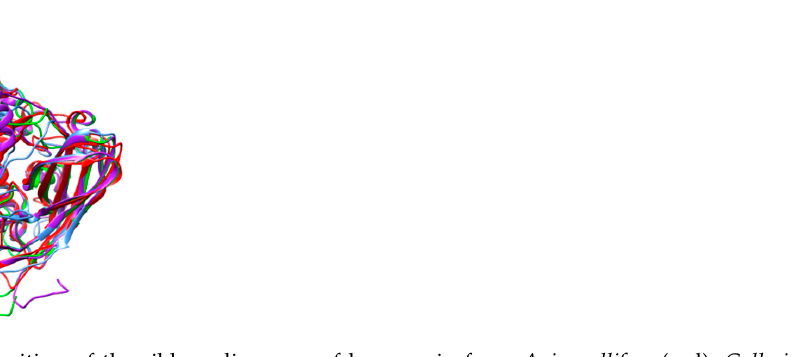
Locusta m. DYFYSDLCNAVYVTPEEYDSDR--VQVRARQYRLNHKAFTYKIYVKSNEEQQASVWIYIGPEYDEYG Galleria m. EYTNFNVTNHLHLNEIECNNVINTKSVLVQRTRLNHKVFTVRVNVKSGVAKHVTVRFFLAPKYDSVG Locusta m. KELSLNEKRHNFVYIDSFVYKLKQGENELVRNSKDFNYYGQLPLSFGKLYQATEAALVGDAQPYIDD Apis m. KLIEIPEDLKYFYEIDNWMLDLNSGLNKITRNSLDCFFTMNDLEPSEIFYEKIETSLNSDKPFTYNE Tenebrio m. RYINISQNRQNFVQFDHFRYSLYSGENVFERNSRQNYFYQNDRTSYRELYQRVLGALYGNGQFSVEA Galleria m. NEIPLNVNTQNFLLIDIFNYELKEGDNLITRVSSDNLLVTDEIDSASVLFNKVDSALQGHGQYMLNM Locusta m. FVHKYGDIERLALPRGTRSGLPLSTFVIIT---PFTHKTISR-SNPYTDDVGS------KVSF-FPF Apis m. RIFGFP--GRLLLPRGKKEGMPFQLFLYVS---PVSSEYNQYNSRIWGGYKFD------KRSFGFPL Tenebrio m. NEAYFGFPRRFLLPKGTYGGYDYQFYVFVSPYVPYQGQQQVDTSKYYYPRVGSGAQYIDNYPLGYPF Galleria m. KQNILKTPRHLLLPKGRVGGMPFVLMVYIS---EYHAPNDVHRGTVETSTIDN-TIRLTSDTLGFPV Locusta m.